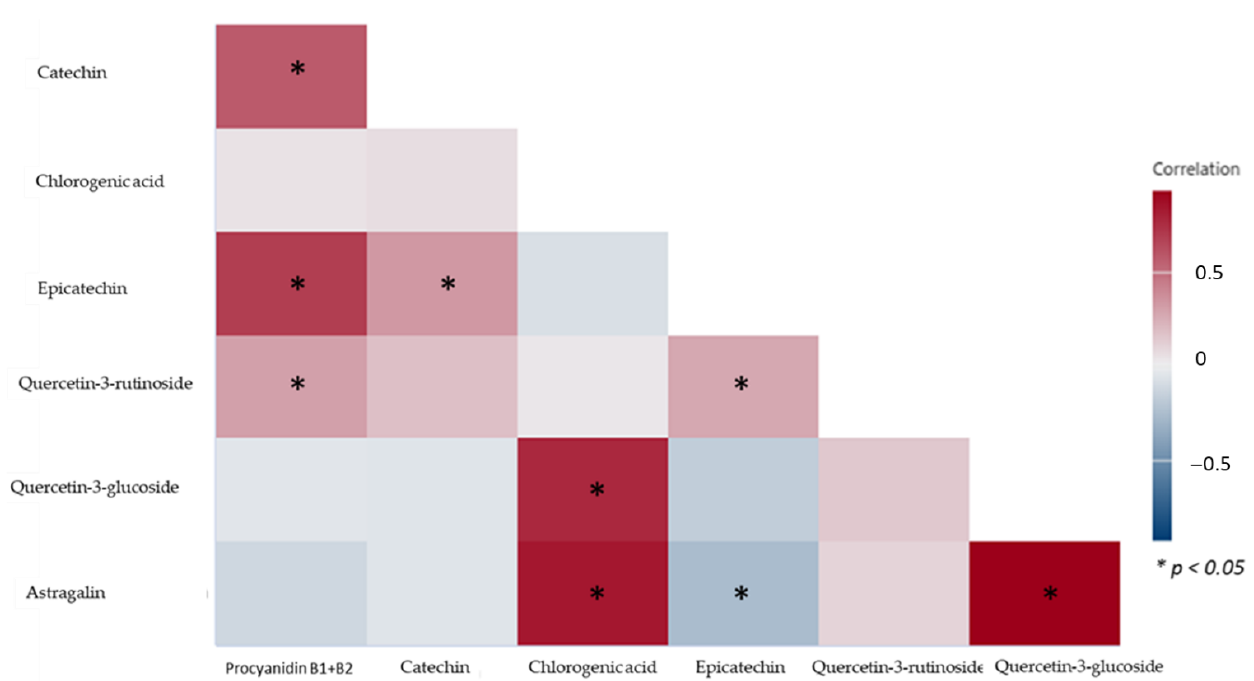
Mean ± SD based on two extracts, each measured twice ( n = 4).